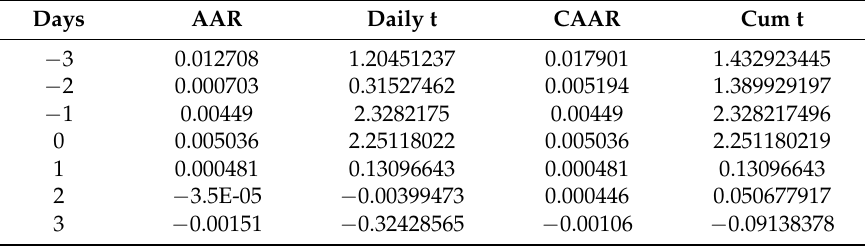
Table 3. Event study results of banks for the second event. Source: Authors’ work.